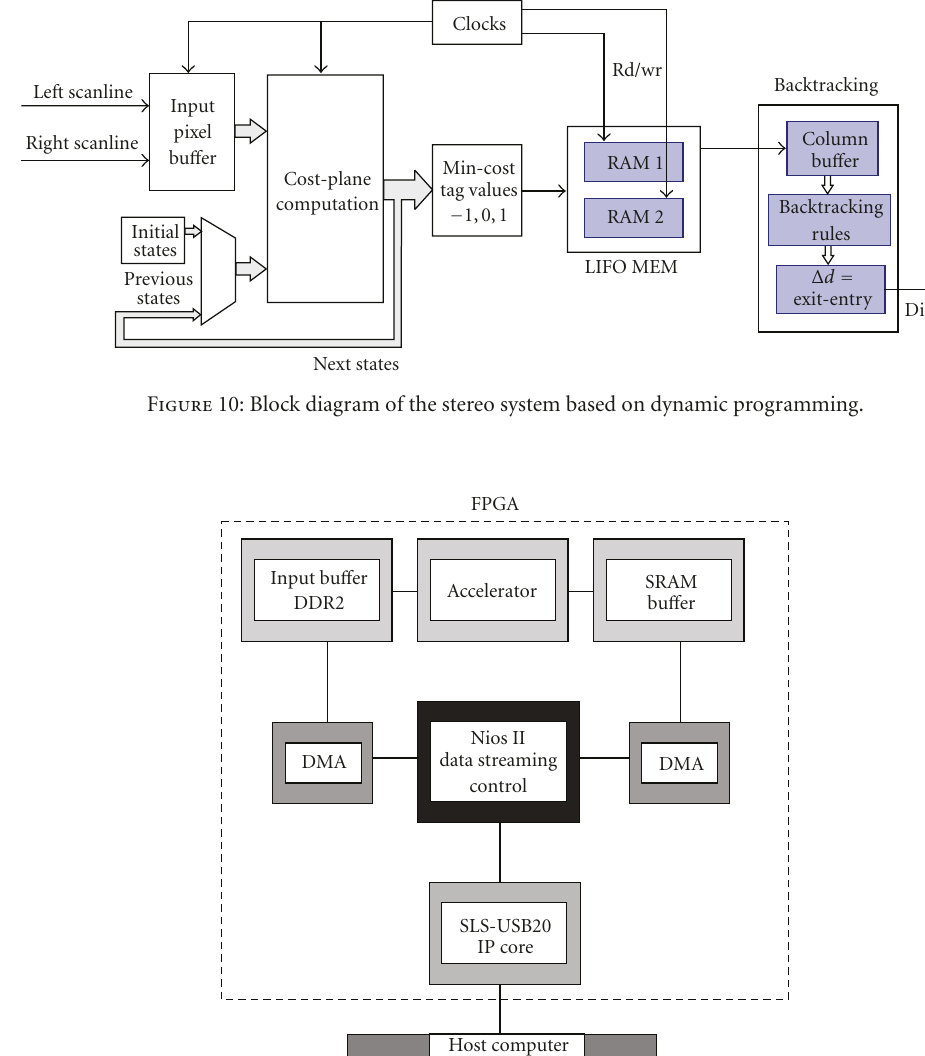
Typical images captured in the laboratory and the resulting depth maps produced by hardware are presented in Section